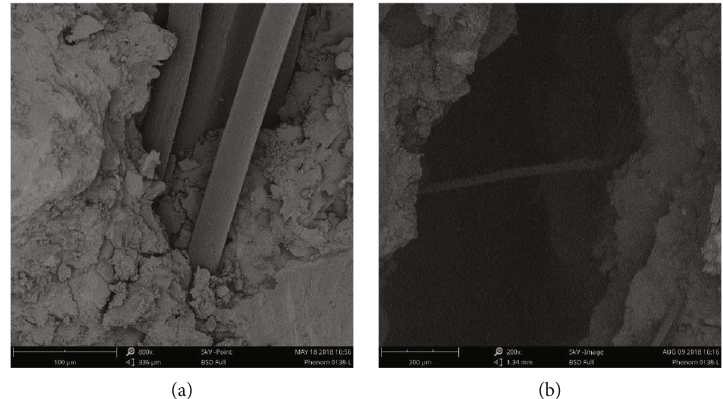
Figure 7: The SEM images of (a) the fi ber embedded in concrete mixture and (b) the fi ber bridging crack.